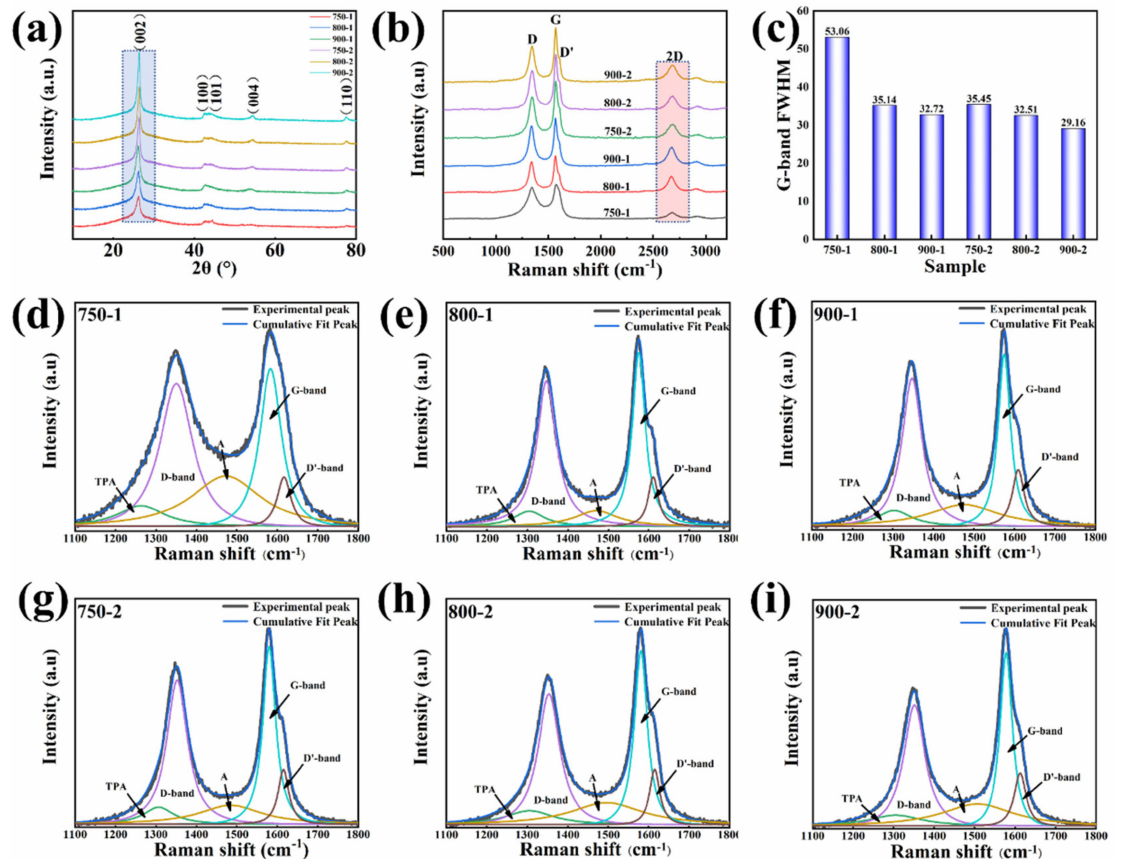
Figure 2. ( a ) XRD patterns of the graphitized pomelo peel; ( b ) Raman of the graphitized pomelo peel; ( c ) FWHM of G-band; Deconvolution of Raman spectra for ( d ) 750-1, ( e ) 800-1, ( f ) 900-1, ( g ) 750-2, ( h ) 800-2, ( i )